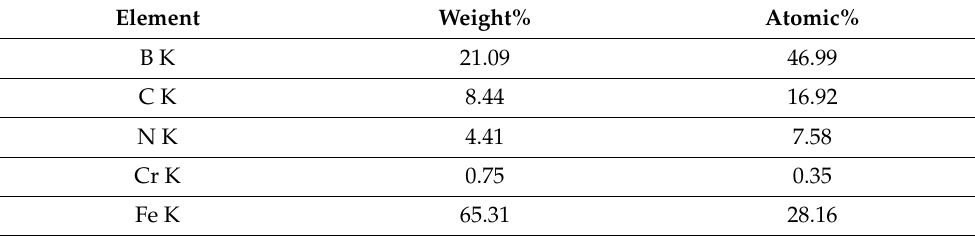
Figure 13. The EDS analysis of treated pins. Table 8 of the EDS analysis of the treated pin reveals that boron is impregnated by 21.09% weight and 46.99% by atomic weight. Table 8. The table of EDS report of a treated pin.